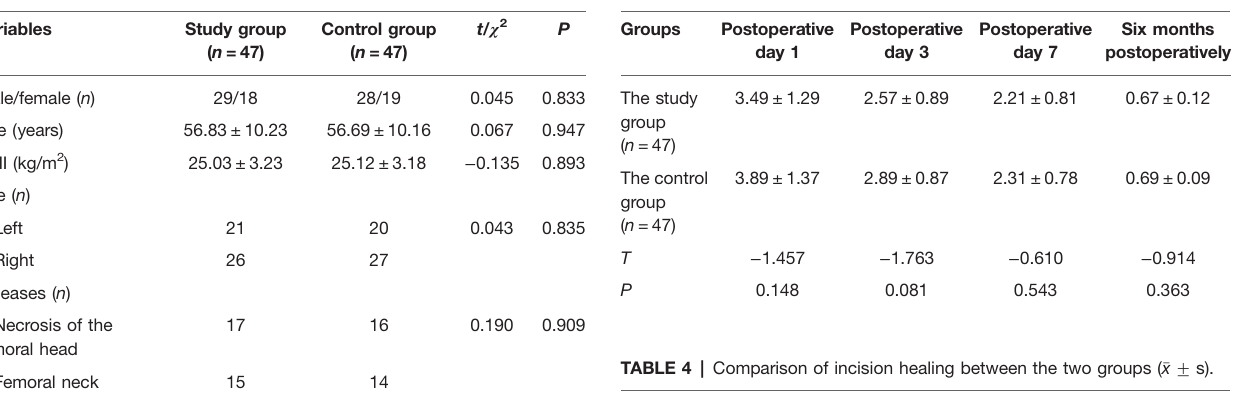
TABLE 1 | Comparison of general data between the two groups. TABLE 3 | Comparison of pain between the two groups ( (cid:1) x + s).